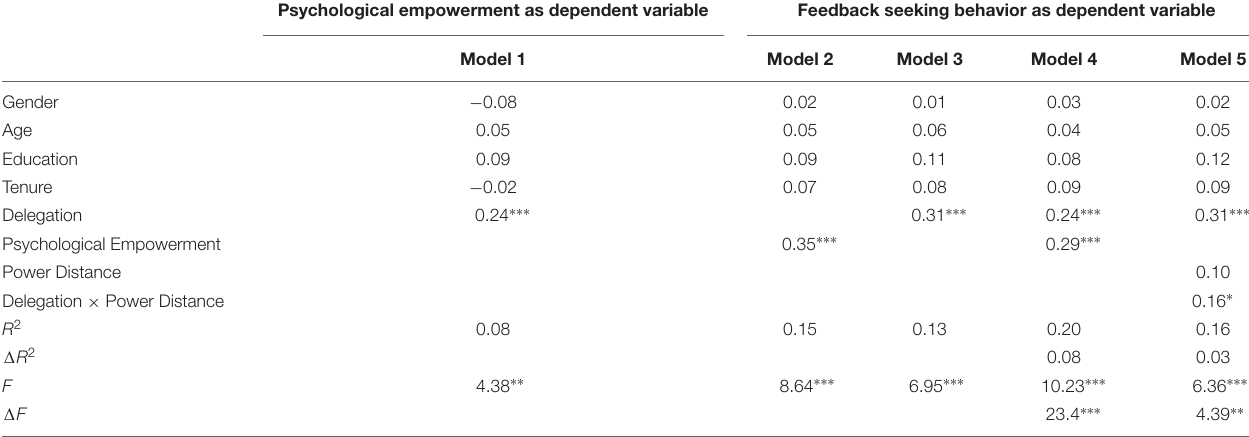
TABLE 2 | Regression results for hypothesis tests.